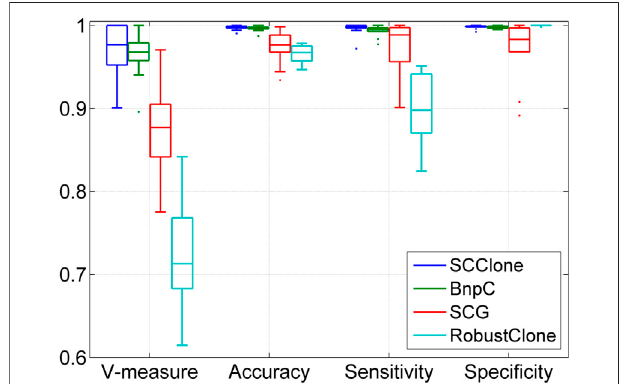
FIGURE 5 | Number of subclones estimated by SCClone, BnpC, SCG, and RobustClone on the simulated dataset D4. The simulated number of subclones changes from 20 to 50. Δ K denotes the difference between predicted and expected number of subclones.